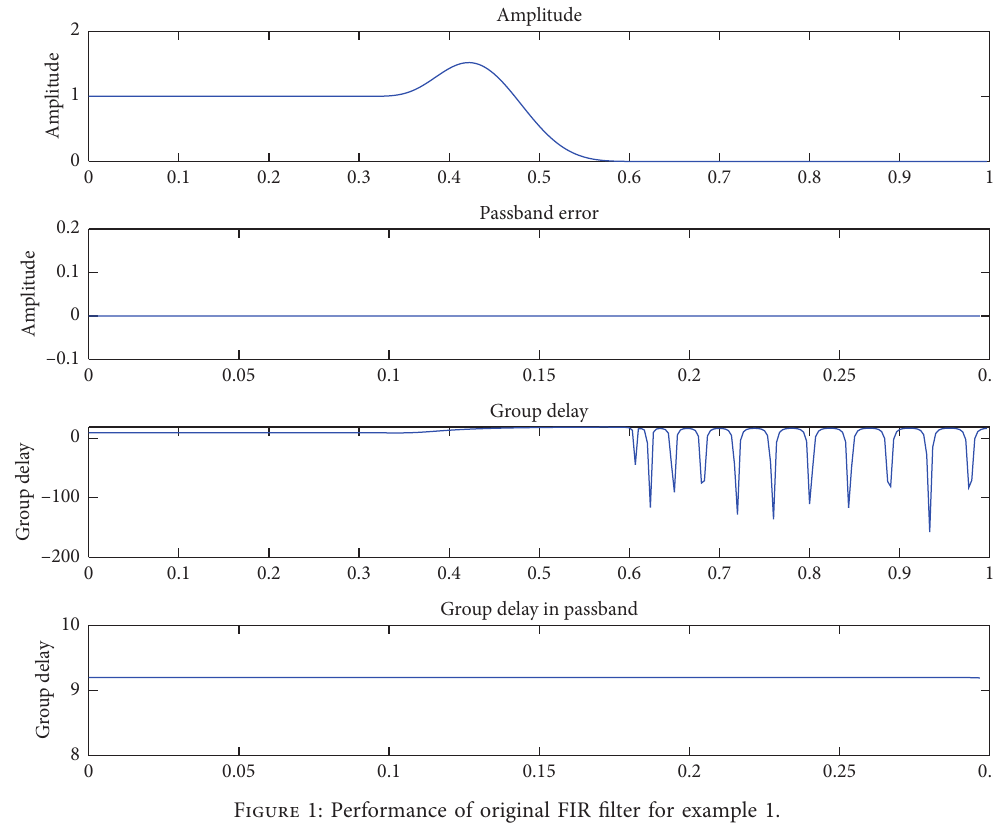
Figure 1: Performance of original FIR filter for example 1.